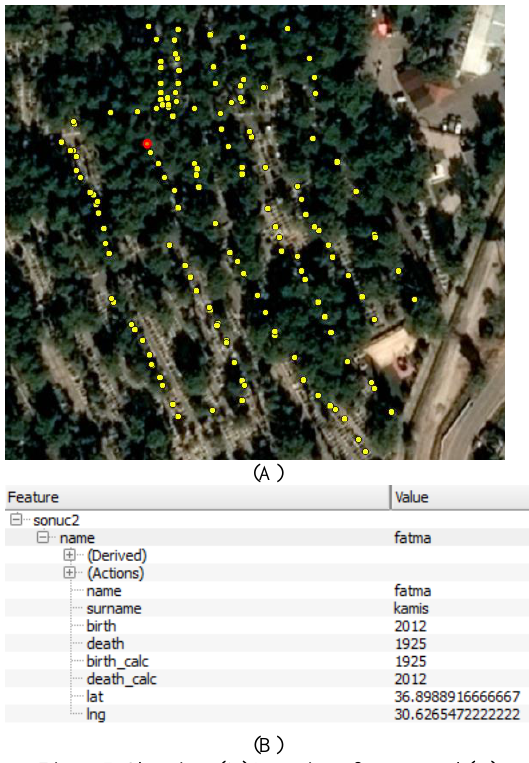
Figure 7. Showing: (A) Location of graves and (B) Attribute table of one of the grave selected (highlighted in red colour in the first